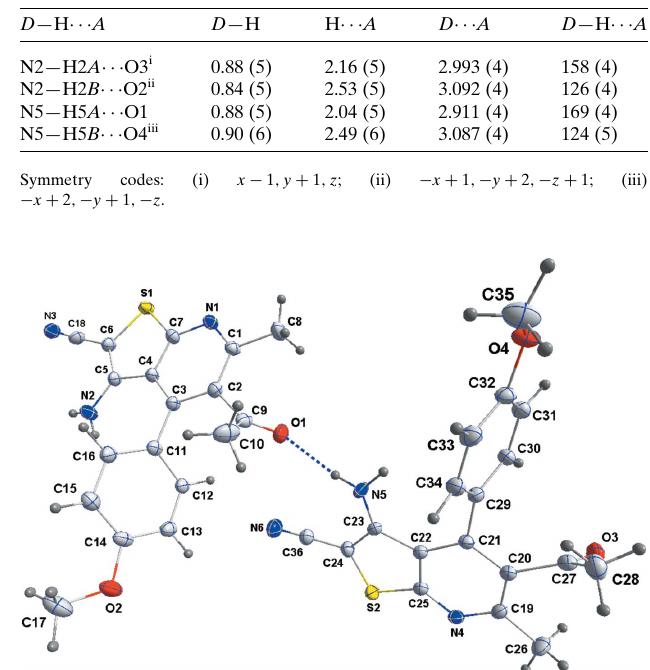
Table 1 Hydrogen-bond geometry (A˚ , (cid:4) ).